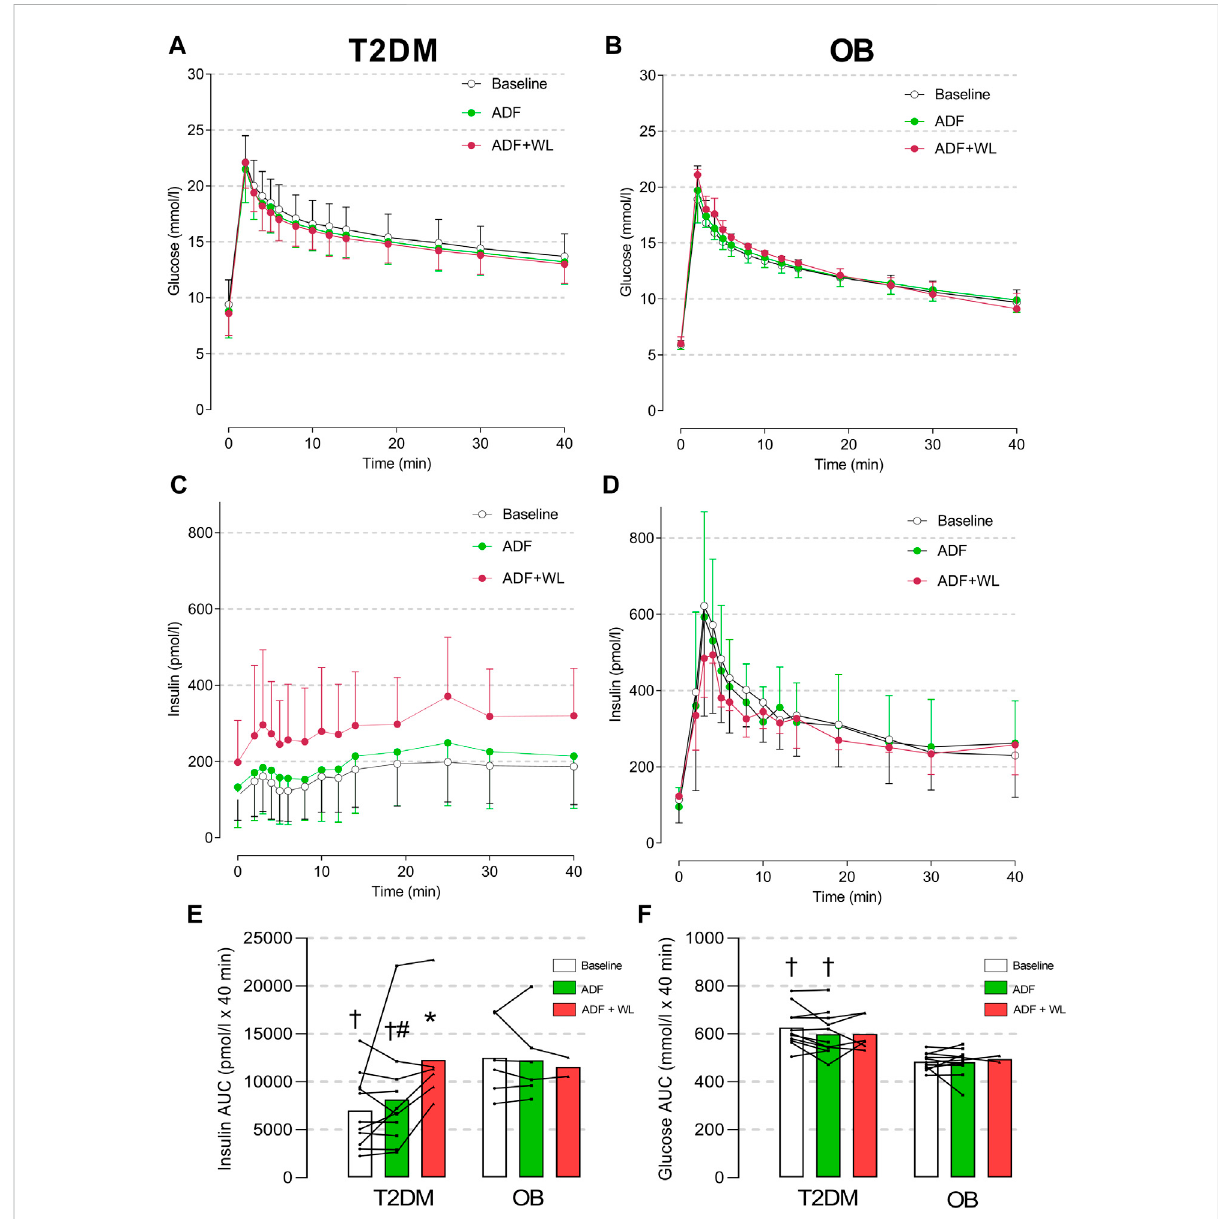
FIGURE 2 Plasma concentrations of glucose (A and B) and insulin (C and D) in response to an intravenous glucose tolerance test (IVGTT) in patients with obesity (OB; (B and D) and type 2 diabetes (T2DM; (A and C) The participants were studied at baseline (mean of two baseline test are shown; T2DM n=11,OBn=11),after3 weeksofalternate-dayfasting(ADF)withdoubledietonnon-fasting days(T2DMn=11,OBn=6)andafterfurther3 weeks ADF with ad libitum diet (i.e. weight loss was allowed (ADF + WL); T2DM n = 6, OB n = 2)) (see Figure one). In column graphs are shown